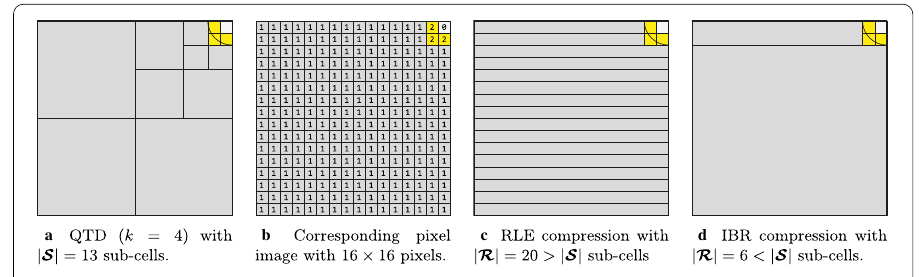
Fig. 14 Artifact of the performance of the RLE algorithm. For this setting the RLE method performs worse than the QTD, i.e., the number of integration sub-cells is increased, while the IBR algorithm is not adversely